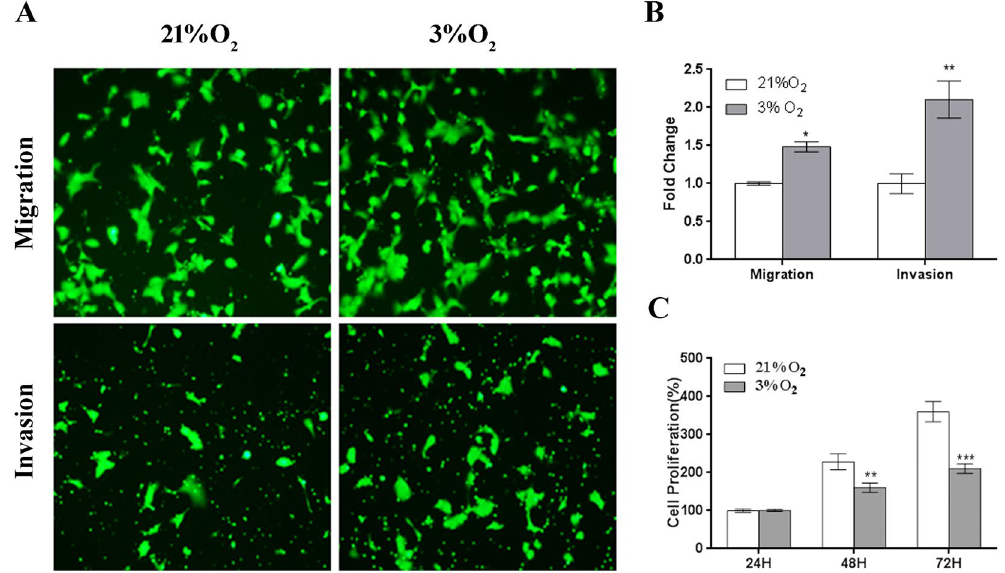
Figure-3. The migration and invasion capacities of JEG3 cells are up-regulated following exposure to 3% O 2 , whereas the proliferation capacity is inhibited. ( A ) Images depicting the migration and invasion of JEG3 cells exposed to 3% or 21% O 2 . ( B ) The fold change in the cell number relative to the control (21% O 2 ) from three independent experiments. The quantitative data are expressed as the mean ± S.E.M. ( * P < 0.05, ** P < 0.01, Student’s t-test) ( C ) The proliferation capacity of JEG3 cells exposed to 3% or 21% O 2 for 72 h. ( ** P < 0.01, *** P < 0.001, one-way